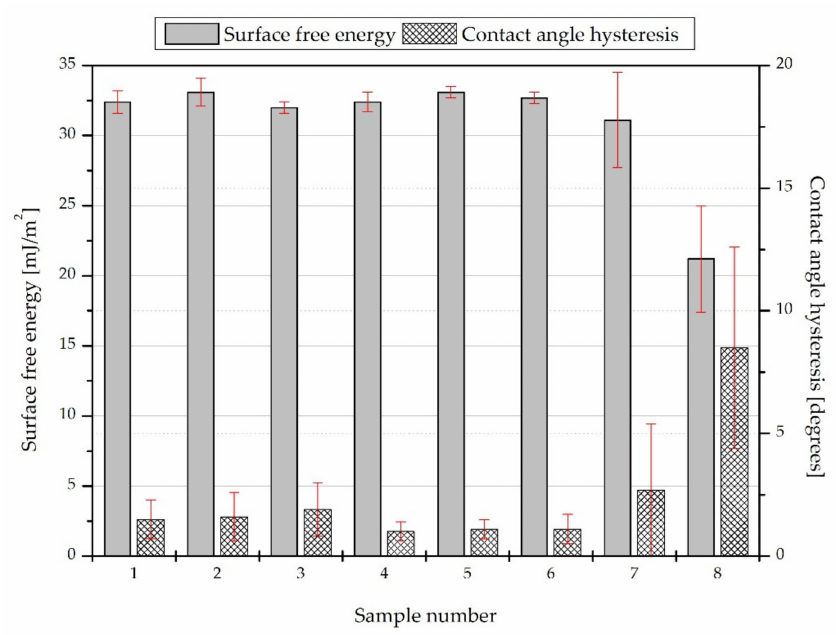
Figure 7. Surface free energies of the obtained